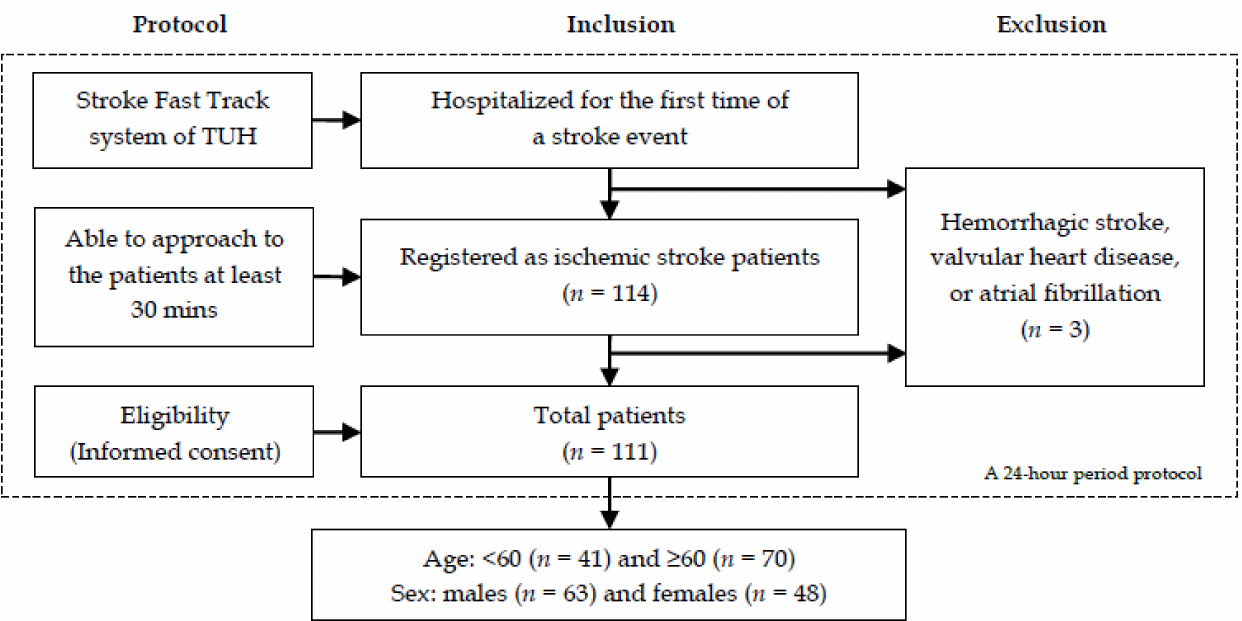
Figure 1. Flow diagram defining the study patients with a first ischemic